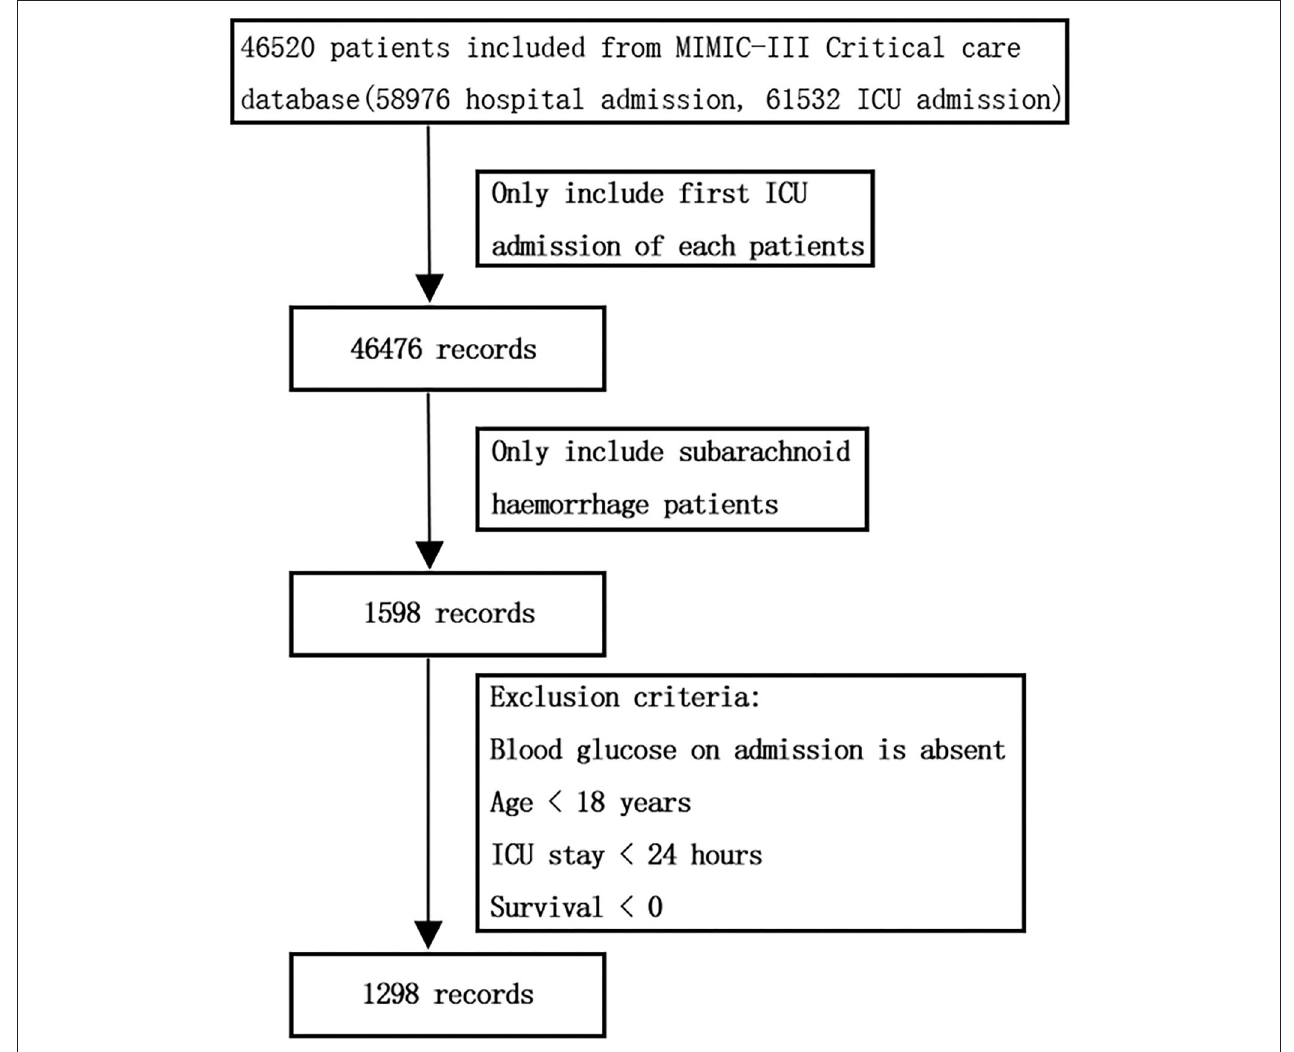
FIGURE 1 | Flow chart of data extraction. ICU, intensive care